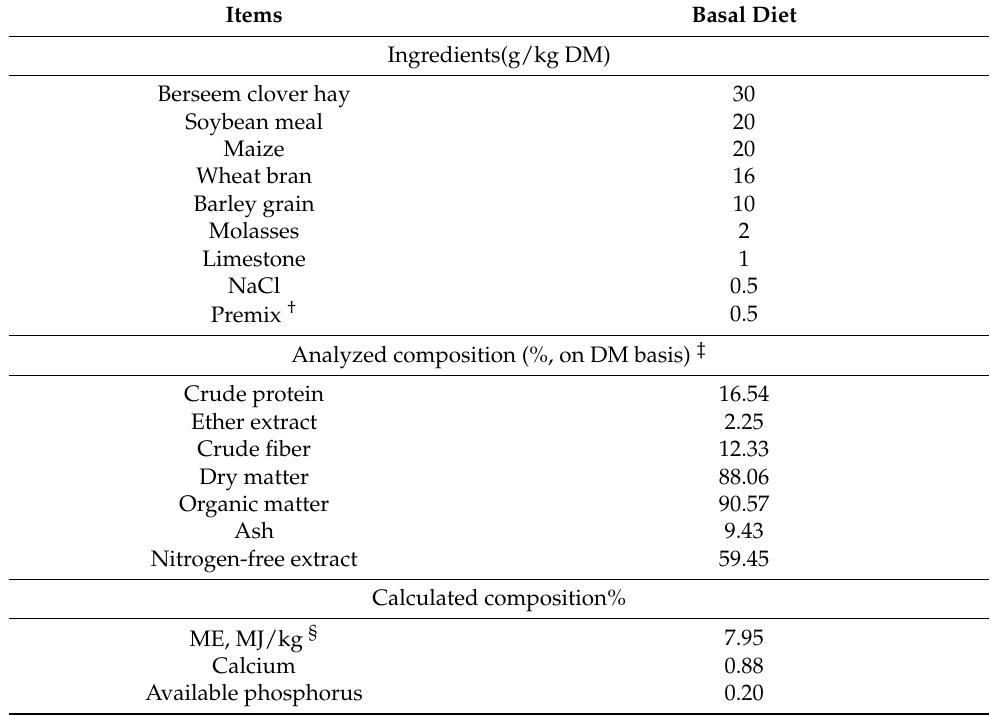
Table 1. Proximate analysis of basal diet components expressed as percentages of dry matter (DM).